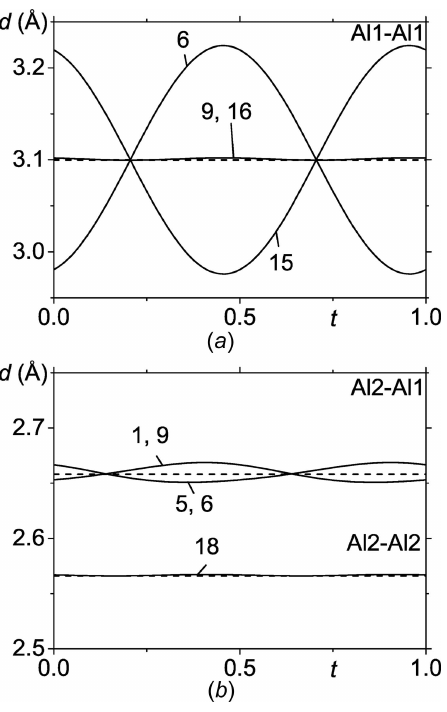
Figure 3 t -Plot of the interatomic distances (A˚ ) d (Al1—Al1), d (Al2—Al1) and d (Al2—Al2) at 70 K, where the first atom is the central atom. The number on each curve is the number of the symmetry operator that is applied to the second atom of the bond pair. Symmetry operators are listed in Table S6 in the supporting information.